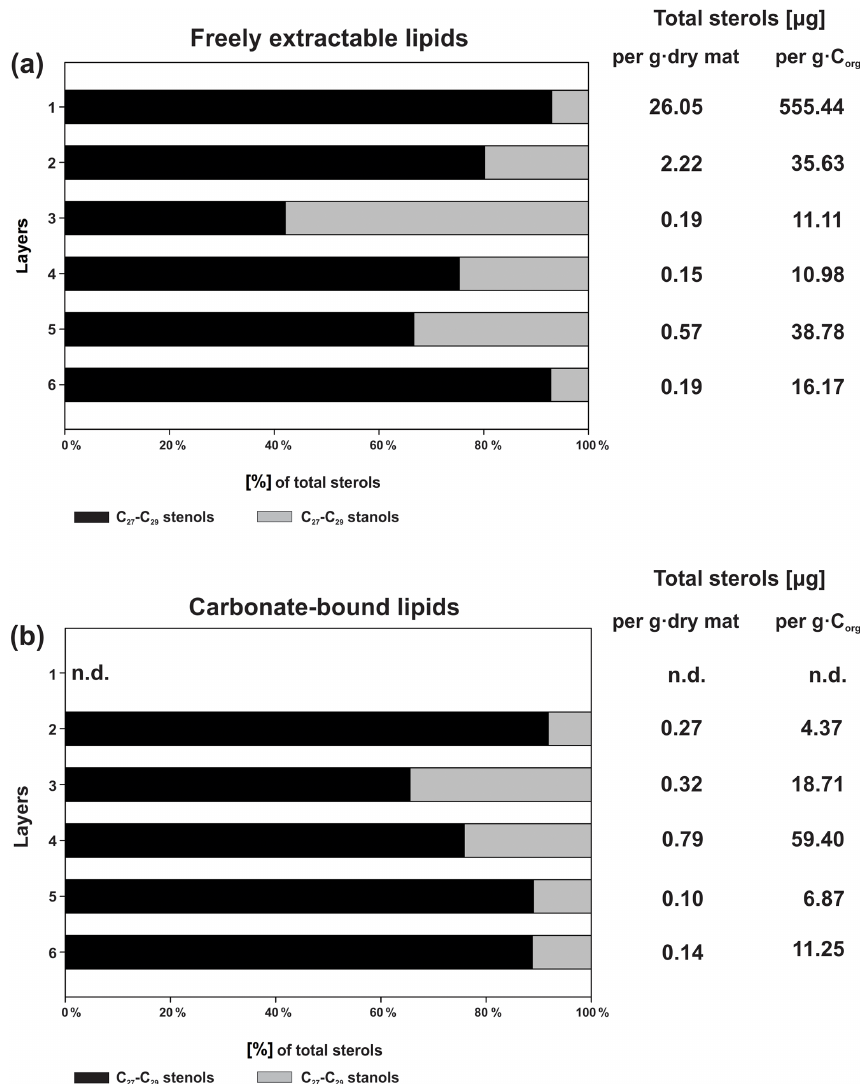
Figure 5. Distributions and concentrations of C 27 –C 29 sterols in the microbial mat layers, (a) freely extractable lipids, and (b) carbonate- bound